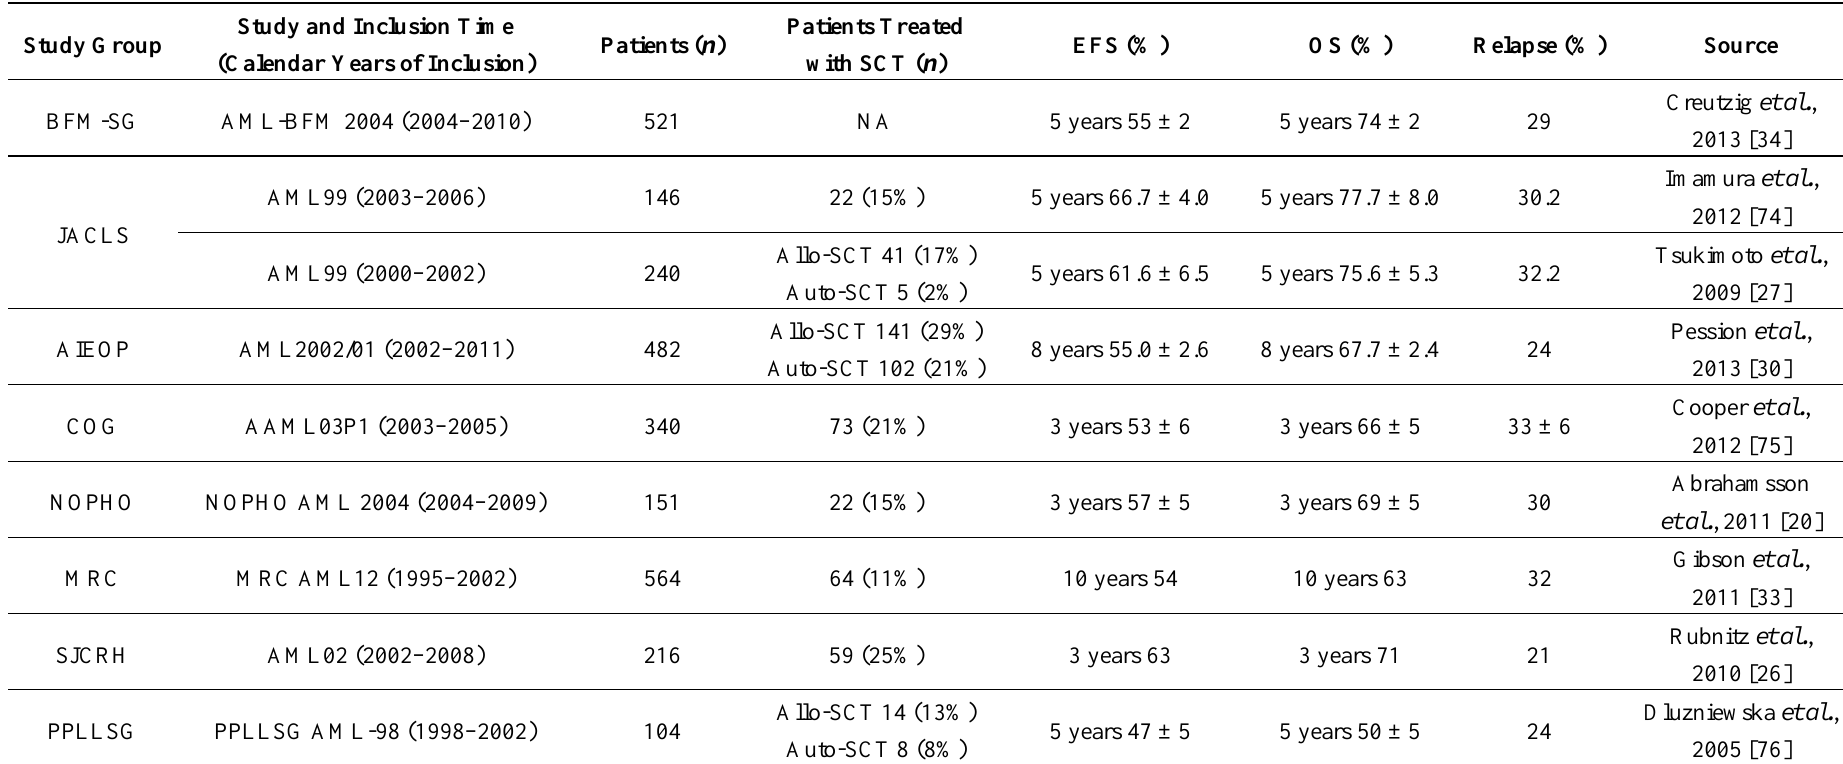
Table 2. Survival of pediatric